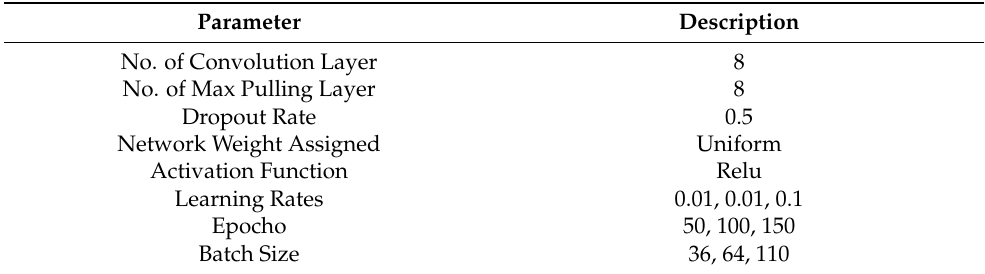
Table 1. Hyper-parameter of deep neural